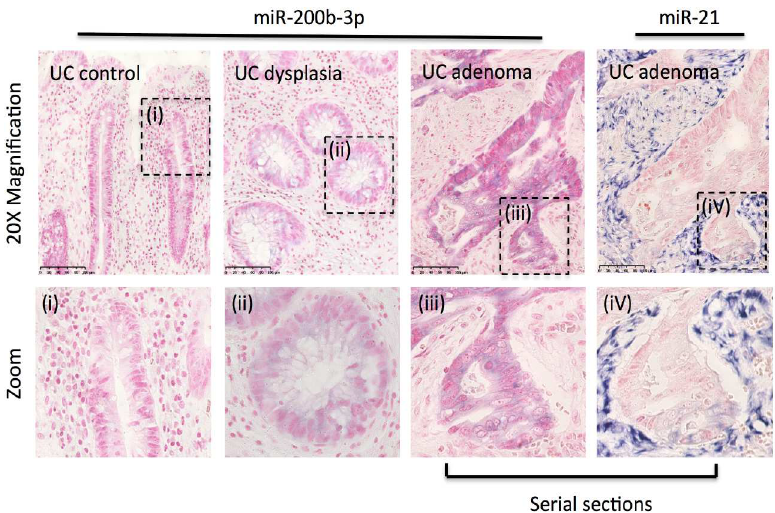
Fig 3. Localisation of miR-200b-3p in ulcerativecolitis-dysplasia and adenocarcinomas Representative imagesof miR-200b-3p staining are shown for UC controls, UC-dysplasia and UC-adenocarcinoma. A pinkcounterstain (nuclearfast red) is usedto visualisethe section,andpurplestainingindicatespositivemiRNA staining.In a serialsectionfrom the UC-adenocarcinoma,miR-21stainingis shownalongsidemiR-200b-3p to demonstrate the differencein cellularlocalisationof thesemiRNAin the